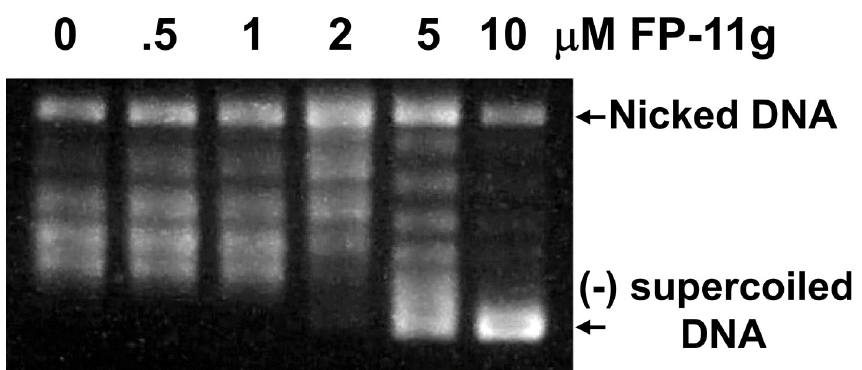
Fig 6. Products of DNA ligation in the presence of FP-11g. DNA ligation of nicked pAB1 plasmid DNA by T4 DNA ligase in the presence of indicated concentrations of FP-11g were performed as described under Methods.